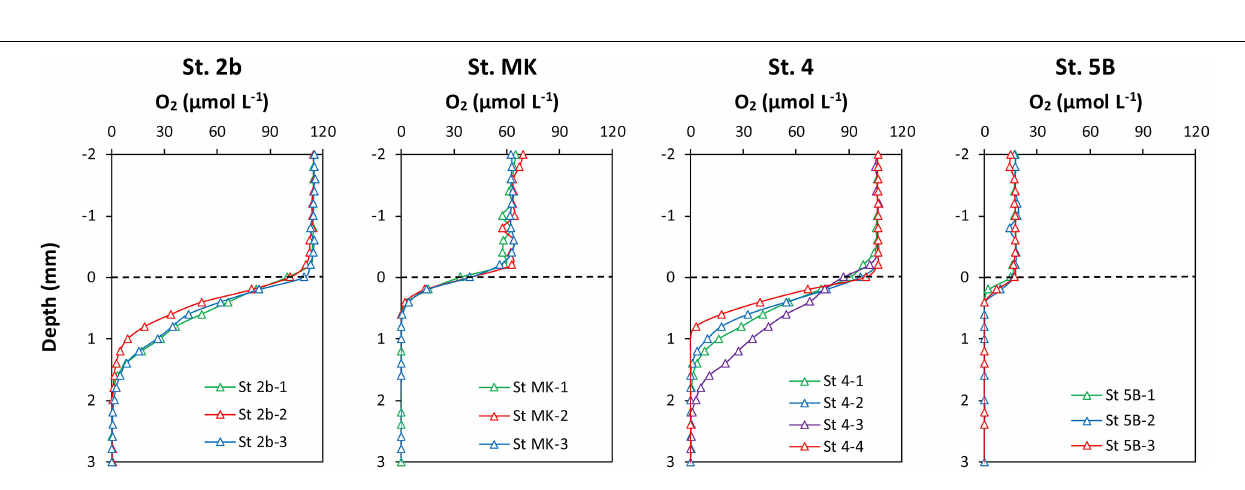
FIGURE 4 | In situ dissolved oxygen micro-profiles obtained in sediments from the four stations on the Louisiana shelf in July 2017. The horizontal dashed line represents the sediment-water interface.